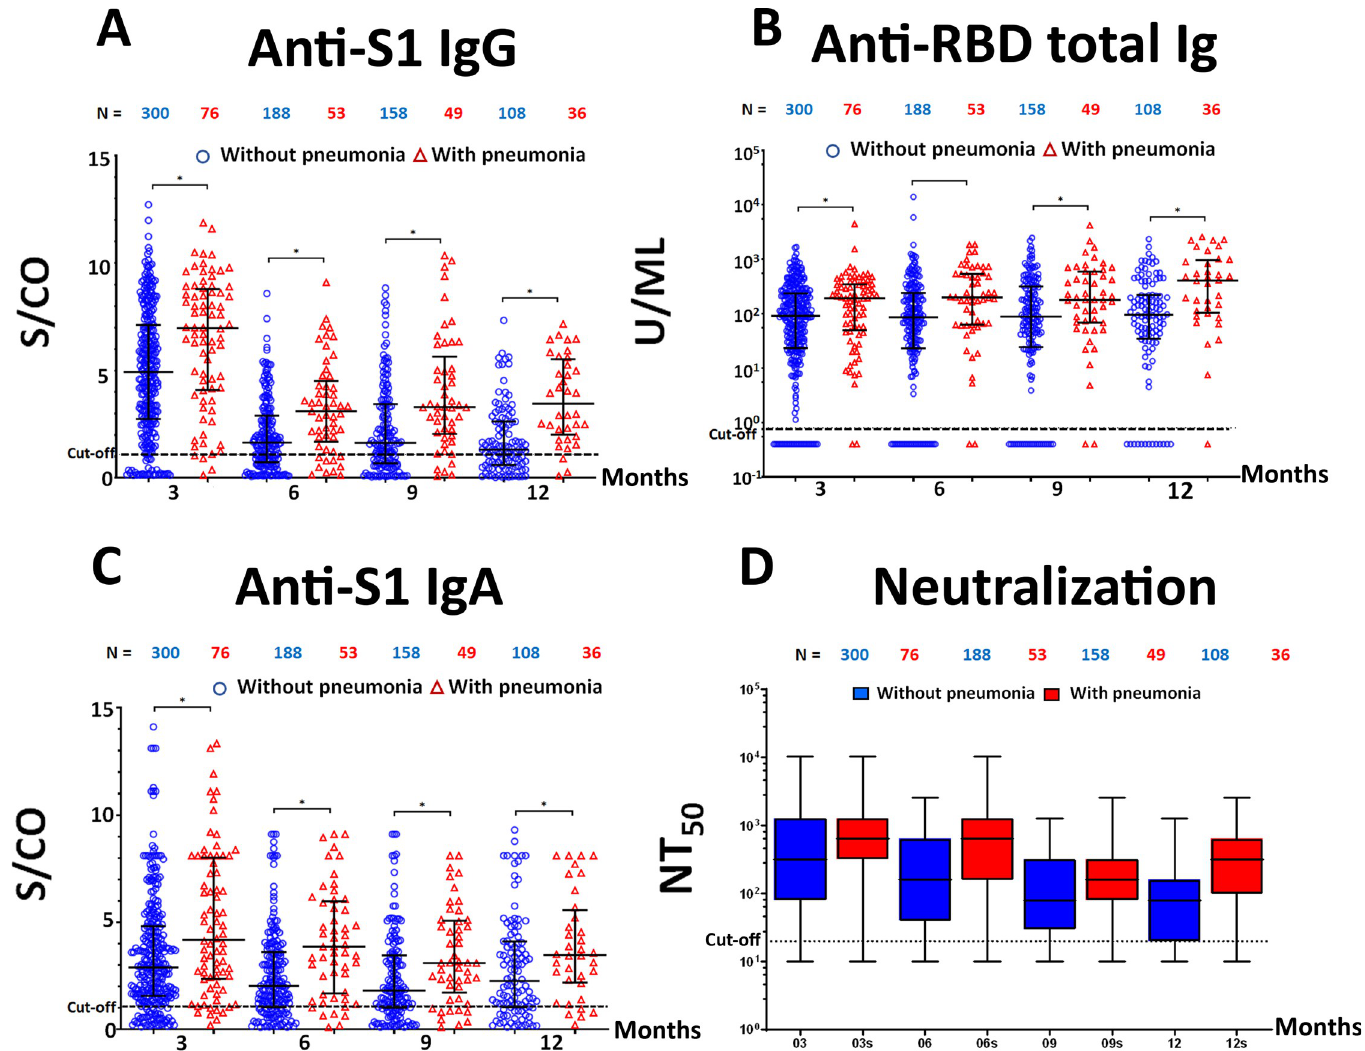
Fig 4. The comparison of antibody levels in the ‘with pneumonia’ (red) and ‘without pneumonia’ (blue) study groups, ( � = p -value < 0.05). (A) Anti-S1 IgG, (B) Anti-RBD total Ig, (C) Anti-S1 IgA, (D) Neutralizing titer (NT 50